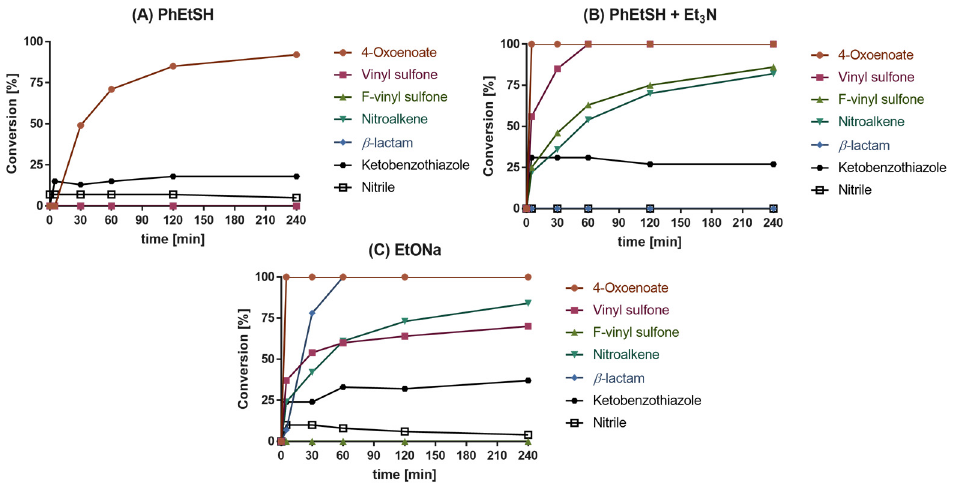
Figure 4. Progress curves of the reactions of the di ff erent warhead compounds with the model nucleophiles PhEtSH, PhEtSH + Et 3 N and EtONa as measured by NMR and LC-MS analysis.